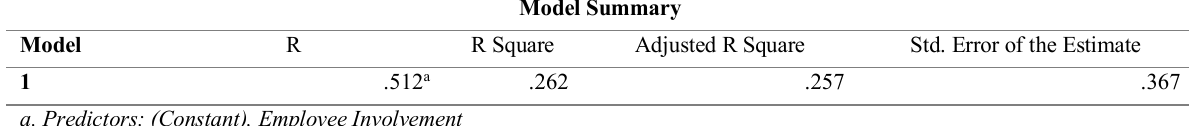
Table 4 (a): Regression Model Summary for Employee Involvement and Employee Engagement